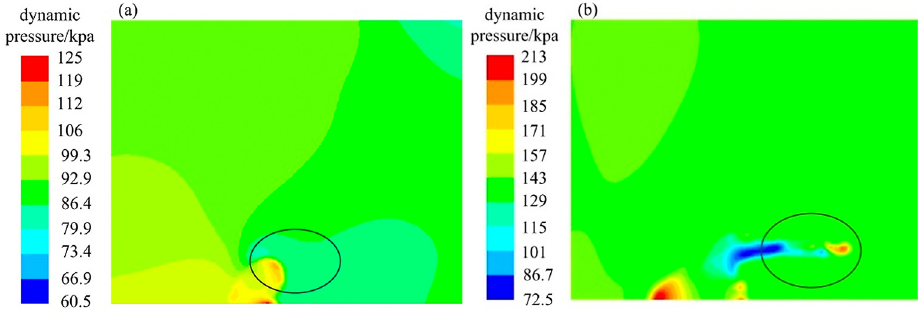
ff erent times: ( a ) t = 22 µ s, ( b ) t = 53 µ